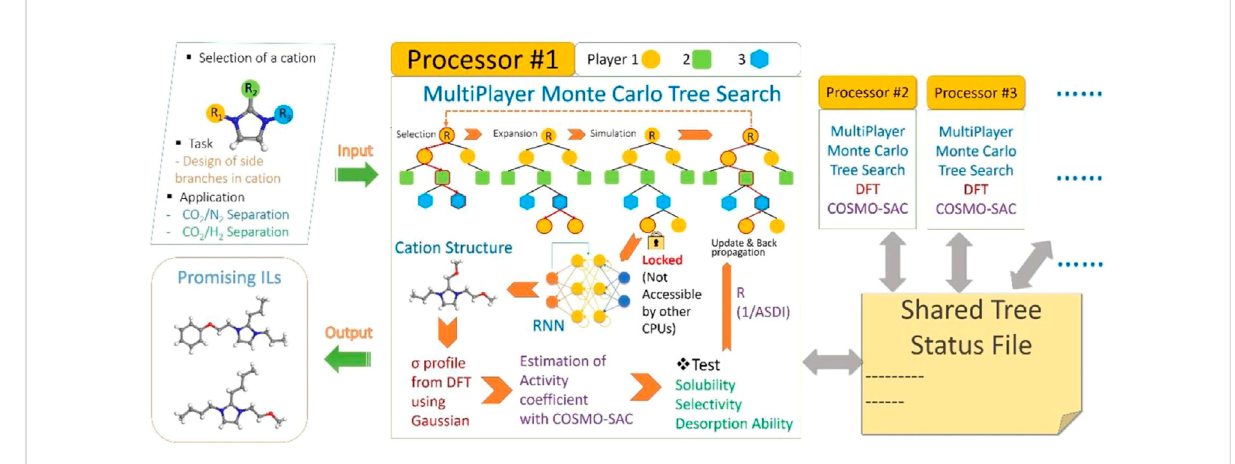
FIGURE 11 A schematic of our algorithm to design an application-speci fi c ionic liquid (Zhang et al.,